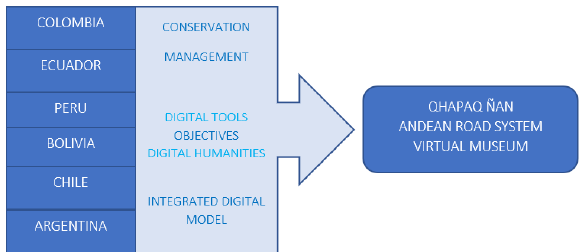
Figure 19. Graphic of Digital Information System for the Qhapaq Ñan – Andean Road System [Point 3.4.5].